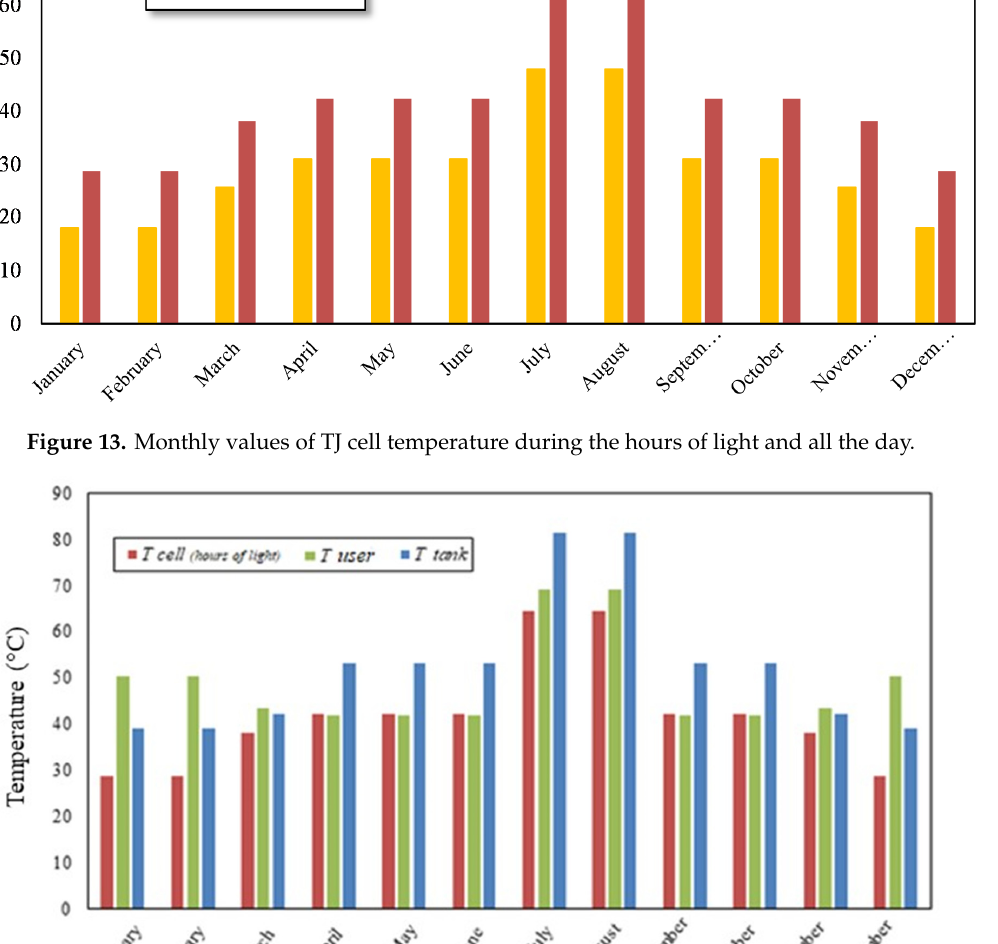
Table 4. Cover level of the thermal energy.